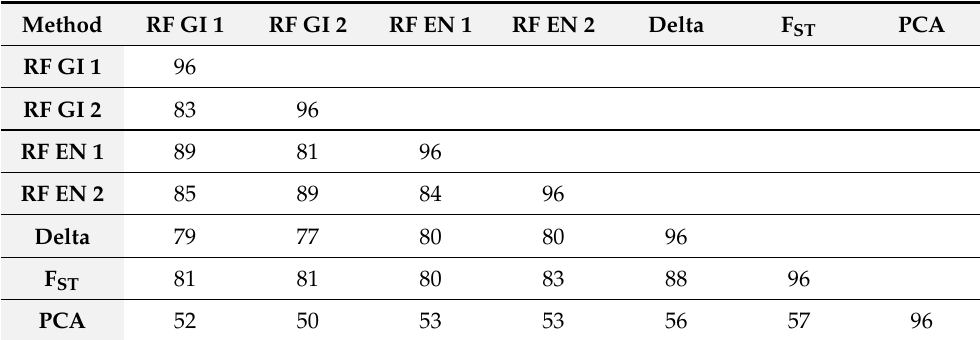
Table 1. Number of SNPs shared between pairs of SNP panels determined with the seven different methods reported in this study (in the diagonal, the 96 SNPs).